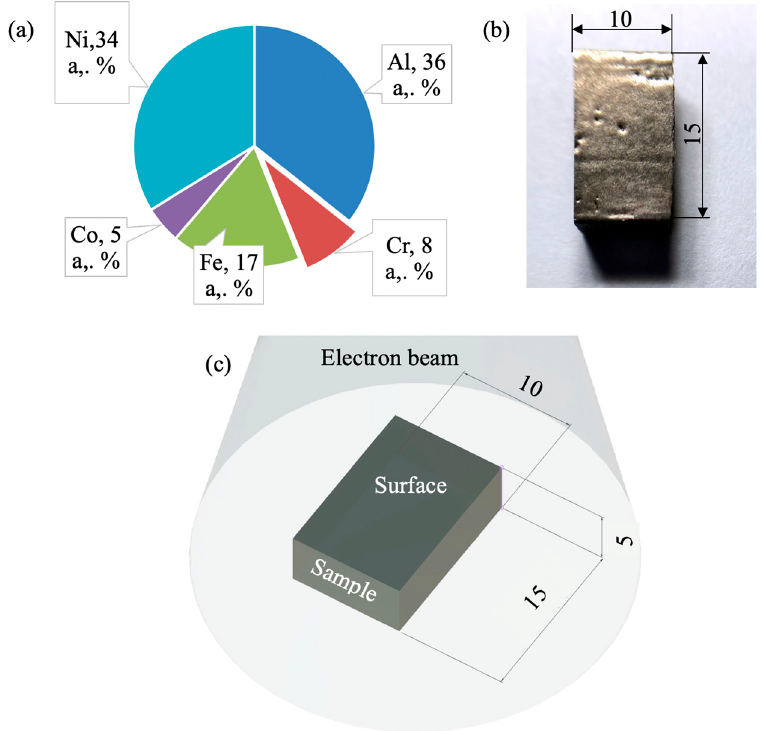
Figure 1. ( a ) XRF analysis data of the HEA under study, ( b ) the geometry of samples irradiated by HCPEB, ( c ) a sample oriented to an electron beam.